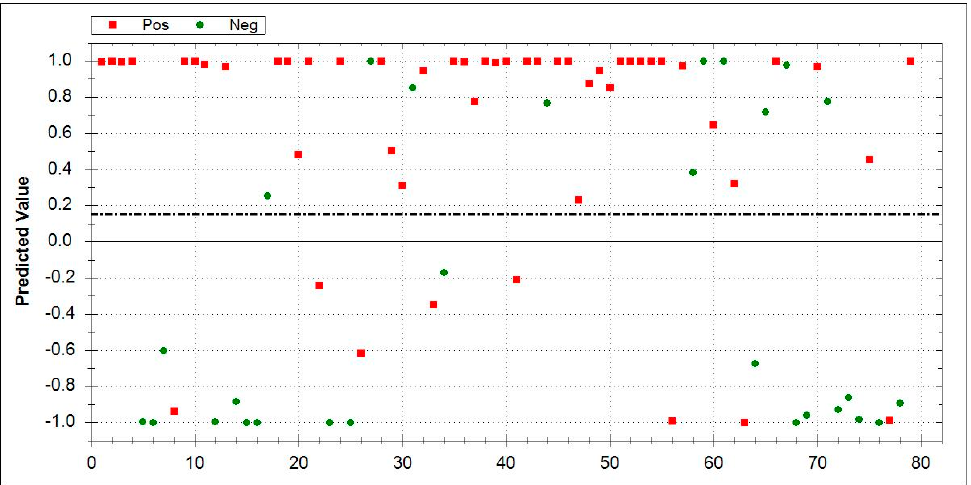
Figure 4. Direct comparison between IPF ( n = 51, red squares) vs. COP ( n = 28, green dots). IPF area 0-1: Red squares indicate correctly-recognized IPF patients. Green dots denote false positive patients. COP area 0- -1: Green dots represent correctly identified COP patients, while red squares mark false negative results. The dotted line is inserted around the threshold for uncertain cases and included two patients. Abbreviations: IPF- Idiopathic pulmonary fibrosis, COP-cryptogenic organizing pneumonia.